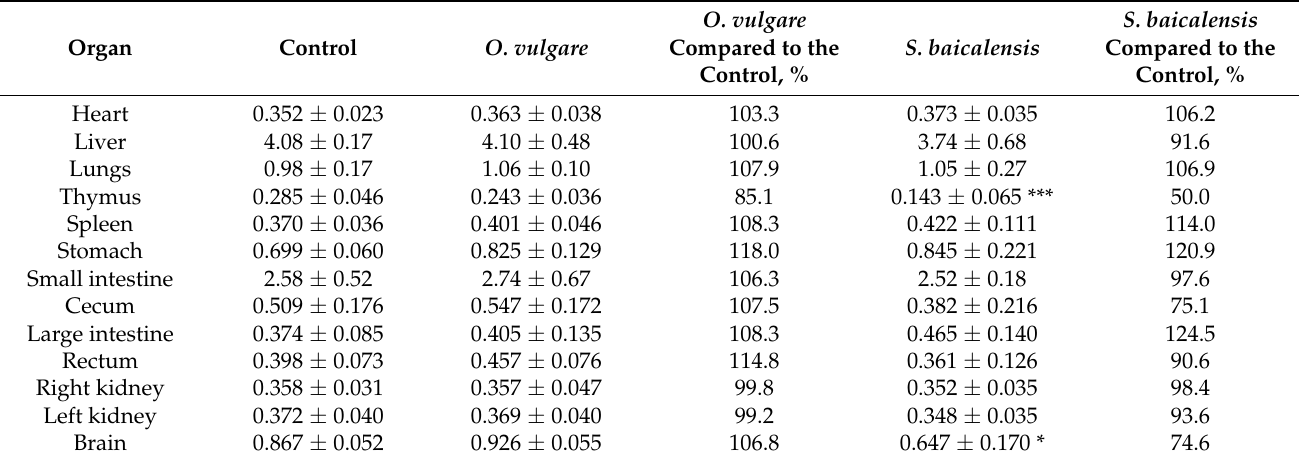
Table 2. Changes in the relative mass of the organs (%) of male rats under the influence of the additions to their rations of Origanum vulgare L. and Scutellaria baicalensis Georgi (x ± SD, n = 8, duration of experiment—30